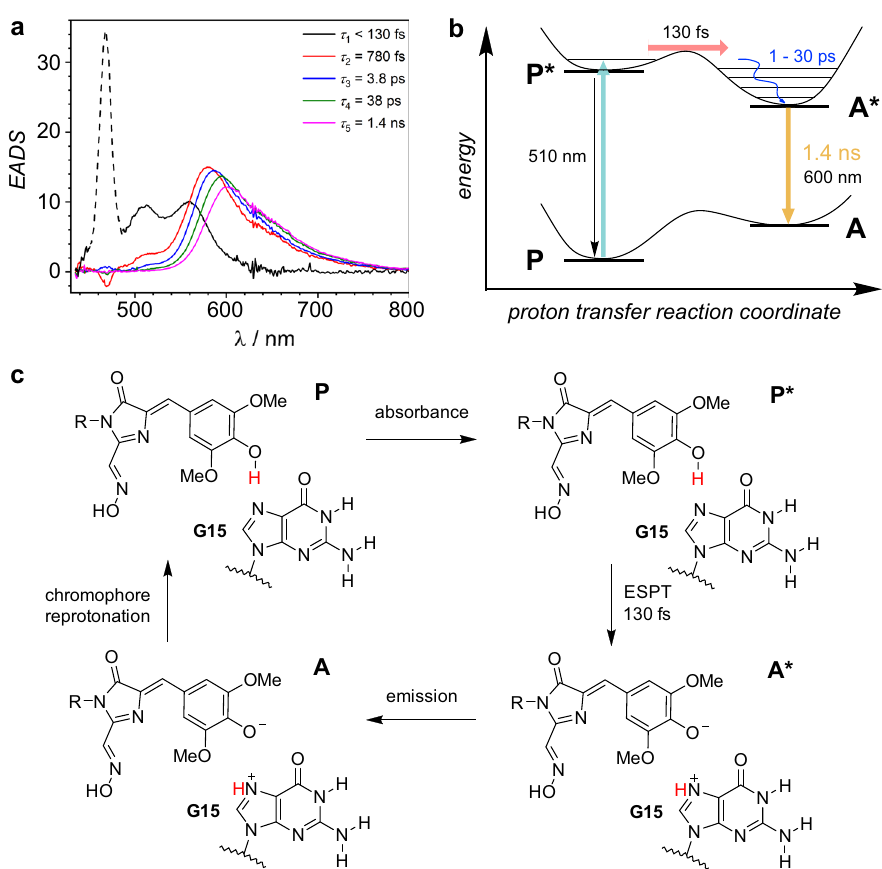
RR Fig. 4 Ultrafast proton transfer in Chili-DMHBO + . a Global deconvolution of time resolved fl uorescence spectra from the fl uorescence up-conversion measurement of Chili – DMHBO + . The peak at 470 nm is a Raman signal of water. The black emission spectrum (peaking at 510 nm) refers to the protonated form of DMHBO + , the red to magenta spectra to the deprotonated form. The time constants τ 2 - τ 4 (0.8 – 38 ps) refer to a continuous dynamic Stokes shift of the emission spectrum caused by solvent and molecular relaxation. The last time constant (1.4 ns) refers to ground state recovery. b Schematic model of excitation, proton transfer, relaxation, and emission processes observed in ( a ). For the ESPT a barrier is assumed because of the distinct differences of the emission spectra of both states. c Scheme of the proposed photo cycle in Chili-DMHBO + . The neutral chromophore (P) is excited from the ground state. The transition from the excited phenol form (P*) to the anionic form (A*) occurs through ESPT in 130 fs. After fl uorescence emission, the ground state P is